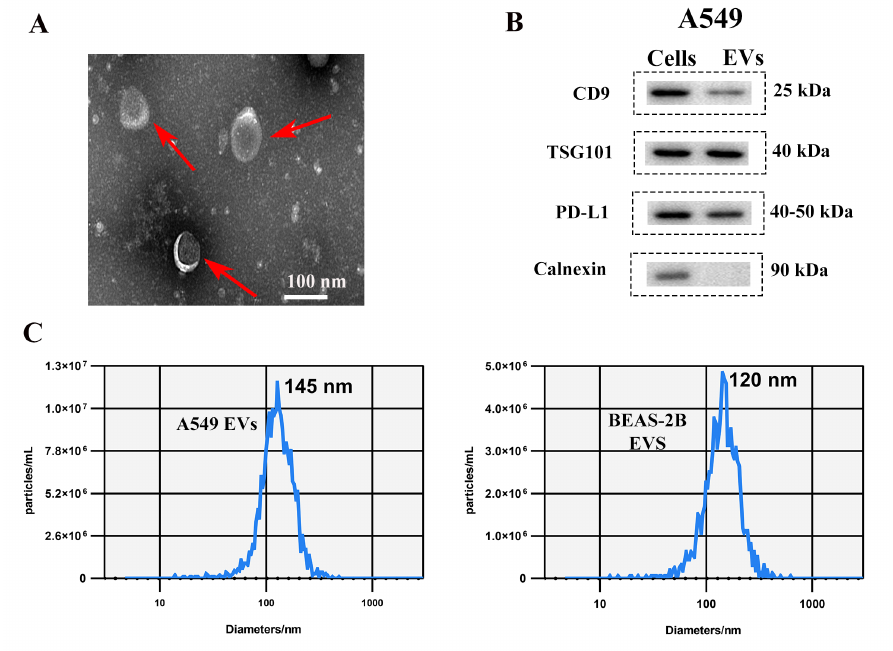
Figure 2. The characterization of canonical features of EVs. ( A ) TEM image of A549 released EVs red arrow points at EVs ( B ) western blot-based visualization of EVs’ positive and negative markers and PD-L1 marker. ( C ) NTA graph showing EVs concentration and size